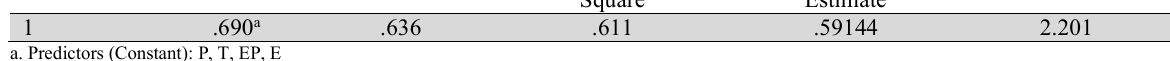
Model Summary b Model